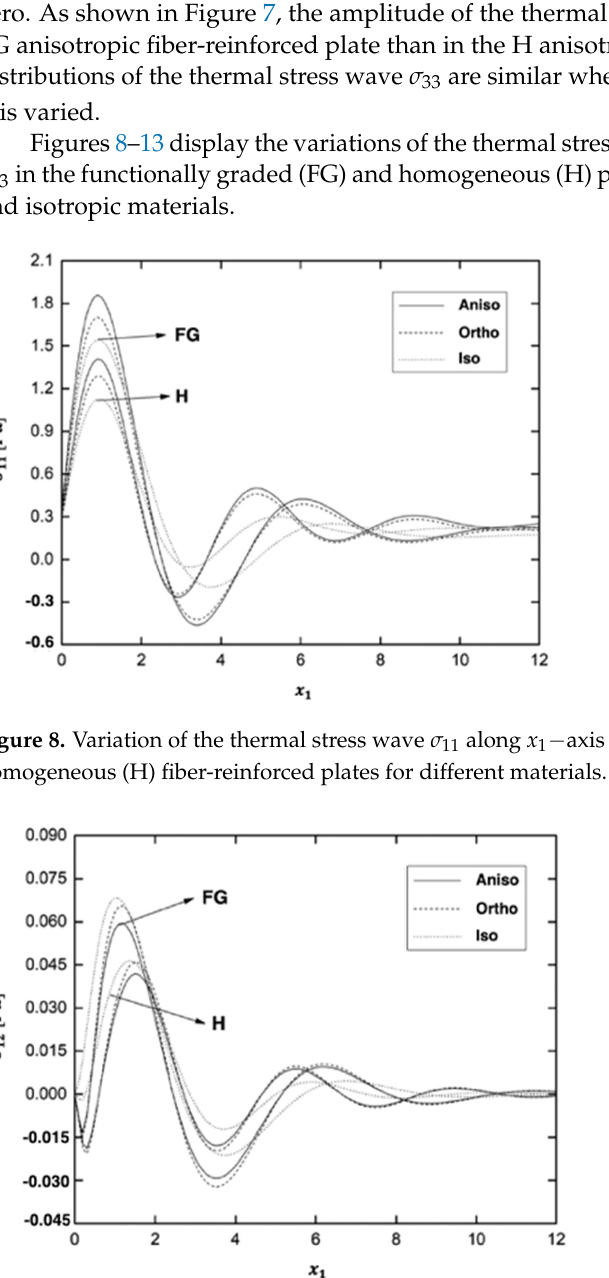
Figure 10. Variation of the thermal stress wave 𝜎 (cid:2870)(cid:2870) along 𝑥 (cid:2869) – axis in the functionally graded (FG) and homogeneous (H) fiber-reinforced plates for different materials. As shown in Figure 11, the behavior of the thermal stress wave 𝜎 (cid:2869)(cid:2871) in the FG case is identical to that shown in Figure 8, it always rises from a positive value. It began with an upward trend and then began to decline. Finally, as the distance x increases, it tends to zero. As shown in Figure 11, the FG fiber-reinforced plate increases the amplitude of the thermal stress wave 𝜎 (cid:2869)(cid:2871) . The distributions of the thermal stress wave 𝜎 (cid:2869)(cid:2871) are similar when anisotropic, orthotropic, and isotropic fiber-reinforced plates are considered.